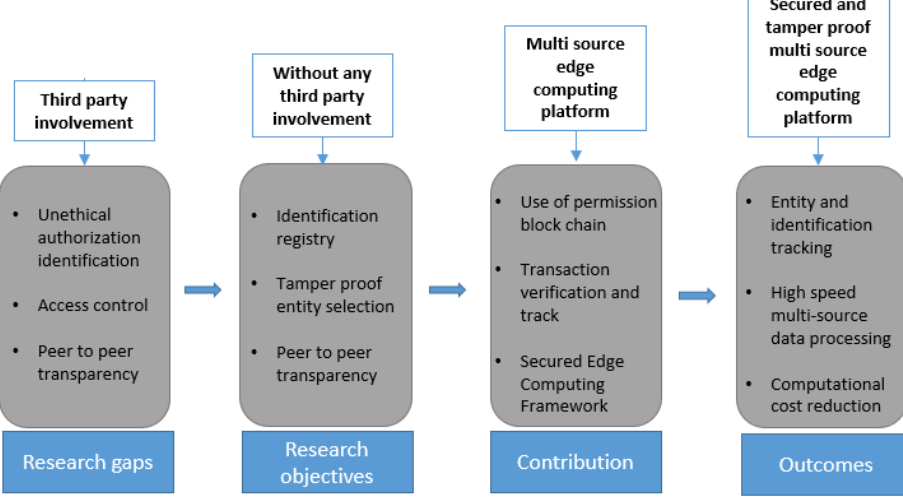
Figure 1. Contribution of the proposed